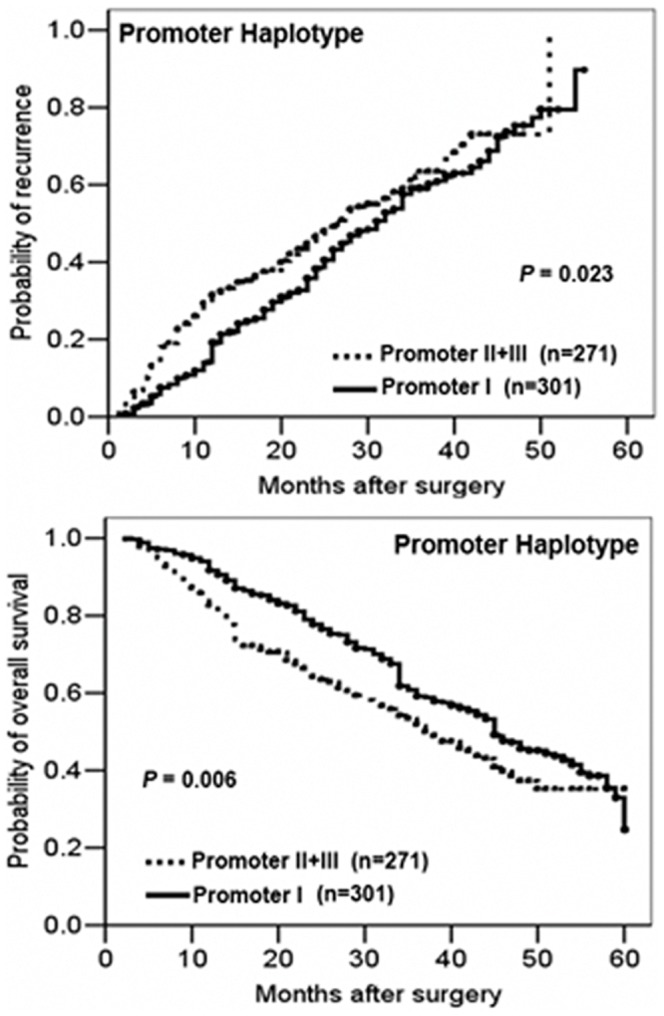
Kaplan–Meier analysis of time to recurrence (TTR) and overall survival (OS) of HCC patients of with promoter I, II and III haplotypes.(A) Earlier TTR was associated with promoter II+III haplotypes compared with promoter I (p = 0.023). (B) Decreased OS was associated with promoter II+III haplotypes compared with promoter I (p = 0.006).